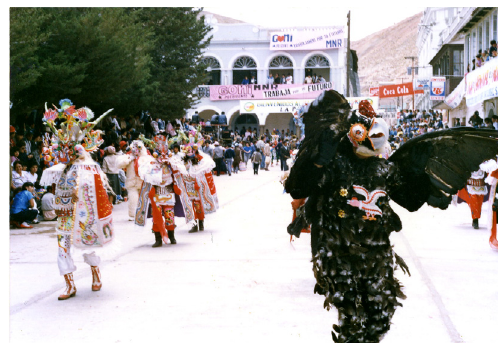
Figure 7. Demon’s festival-II in Bolivia.